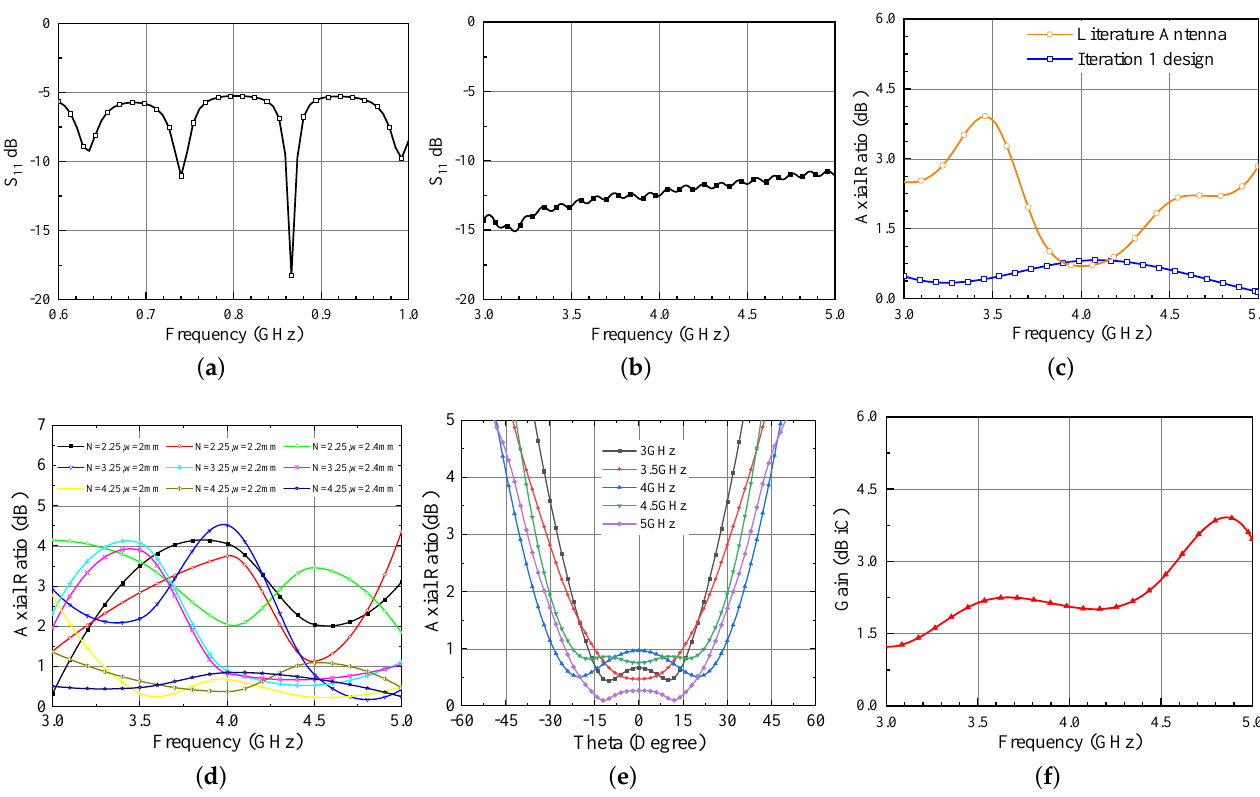
Figure 2. Simulated responses of hybrid UWB antenna ( a ) S 11 for UHF band (normalized to 12 Ω ) ( b ) S 11 for UWB band (normalized to 120 Ω ) ( c ) Axial Ratio v/s Freq ( d ) parametric study of AR optimization ( e ) Axial Ratio v/s Theta ( f )